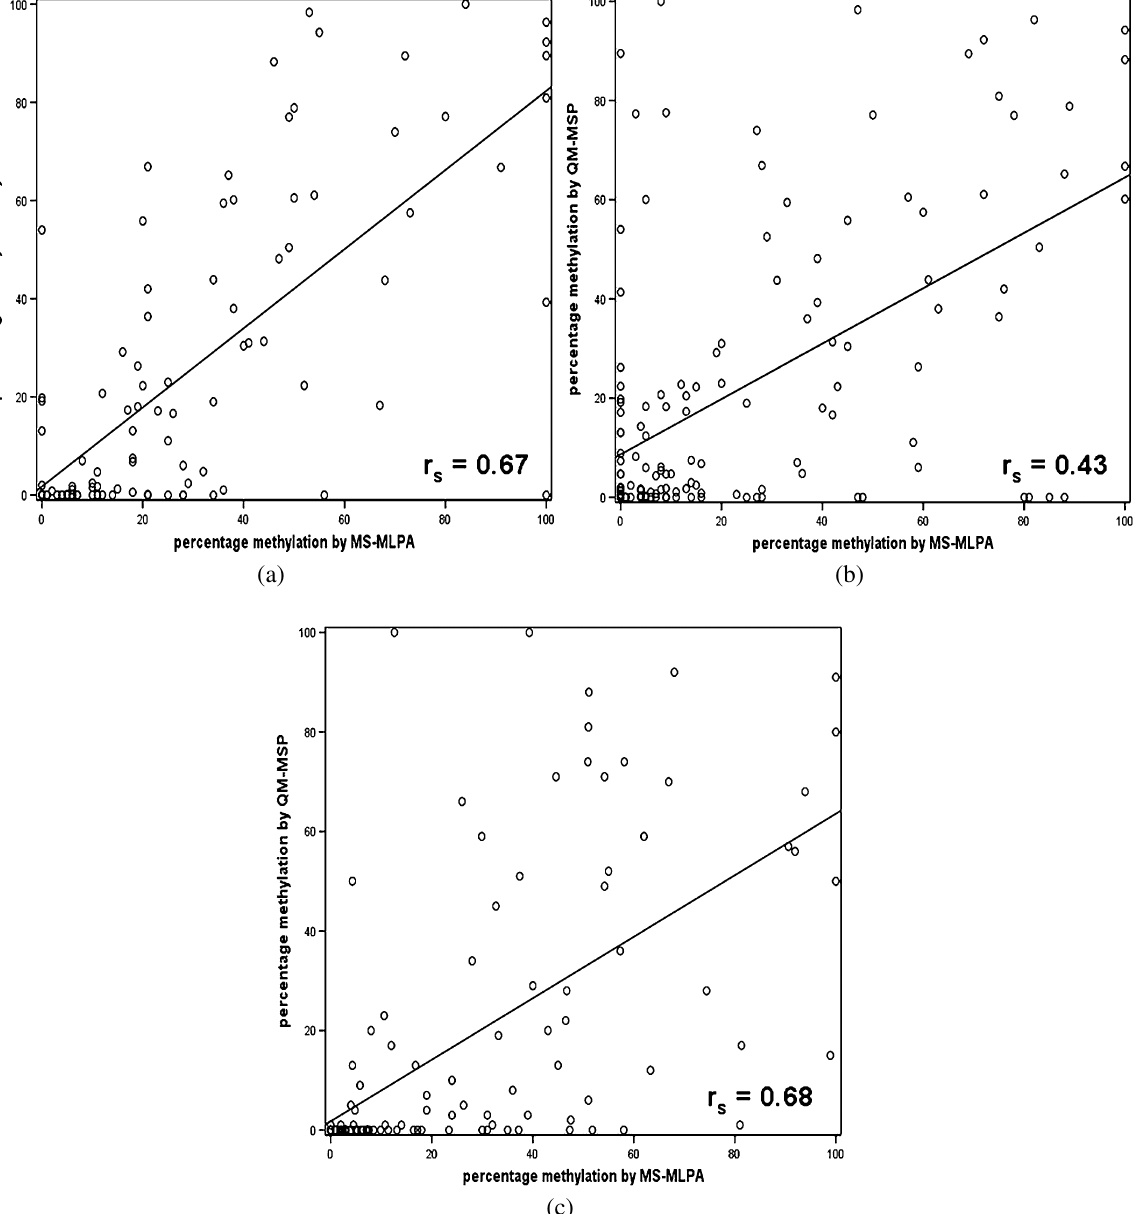
Fig. 2. Regression curve fitting to assess concordance of QM-MSP vs. MS-MLPA based methylation detection in breast cancer according to probe location and tissue fixation ( r s = Spearman correlation coefficient): (a) MS-MLPA versus QM-MSP with overlapping target sequences using DNA from formalin fixed paraffin-embedded tissue; (b) MS-MLPA versus QM-MSP with non-overlapping target sequences using DNA from paraffin-embedded tissue; (c) MS-MLPA versus QM-MSP with overlapping target sequences using DNA from fresh frozen